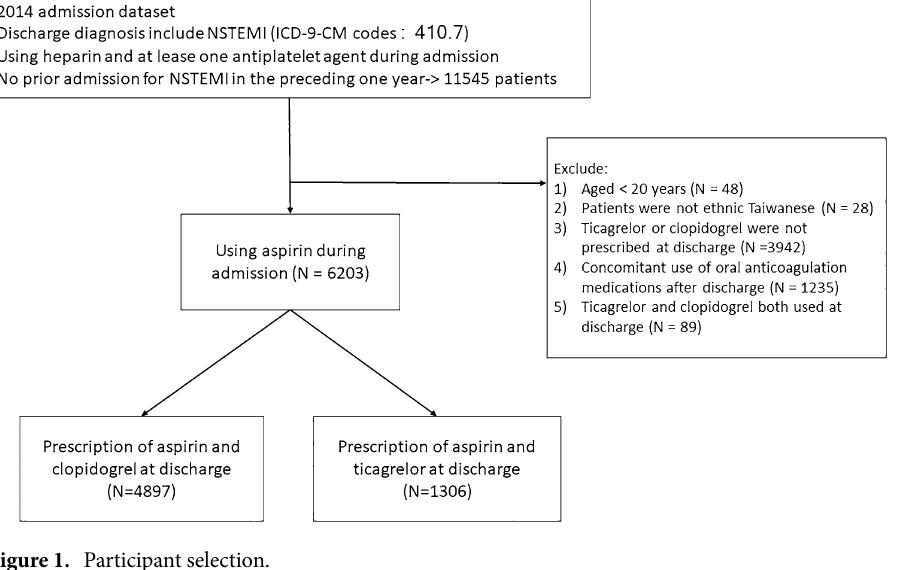
Figure 1. Participant